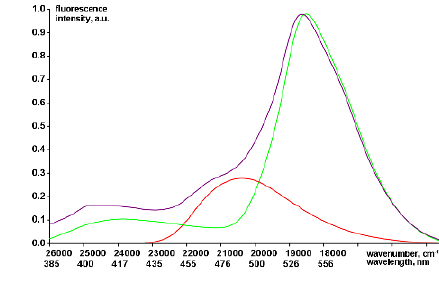
Figure 9. Fluorescence of bis-flavonol in methanol ( λ * = 360 nm, ( λ * = 360 nm, magenta green) and methanol + NaOH aq and λ * = 420 nm, red); see colors in the online version of this paper.